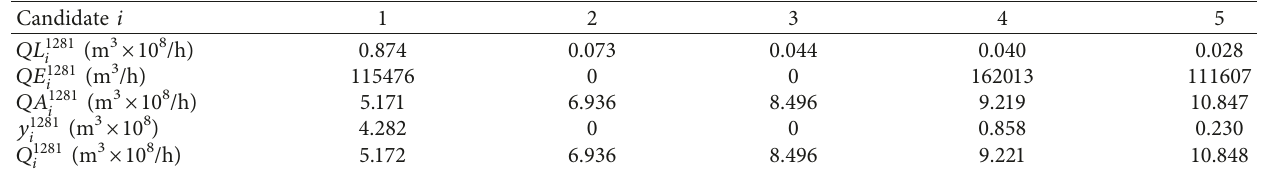
Table 14: Operational decisions under scenario 1281.